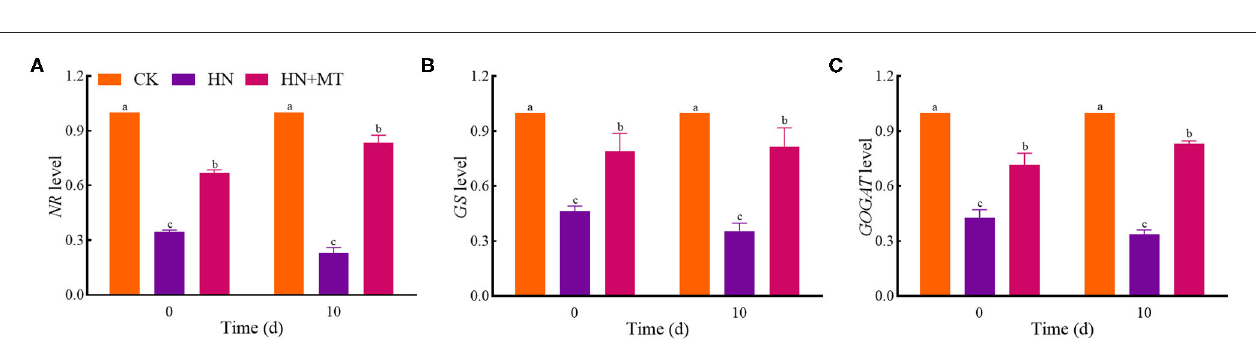
FIGURE 5 | Changes of NR (A) , GS (B) , and GOGAT (C) levels. The groups on the same day followed with the same letter are not significantly different at p < 0.05. Bars indicate the SDs of the